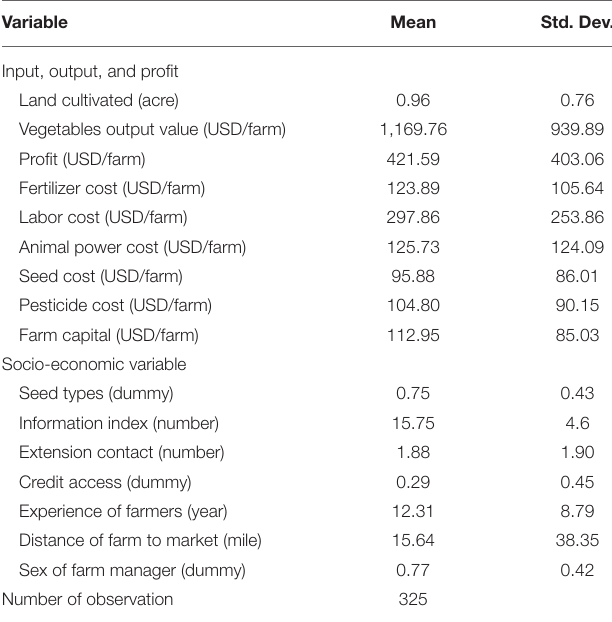
TABLE 1 | Descriptive statistics of variables used in profit efficiency